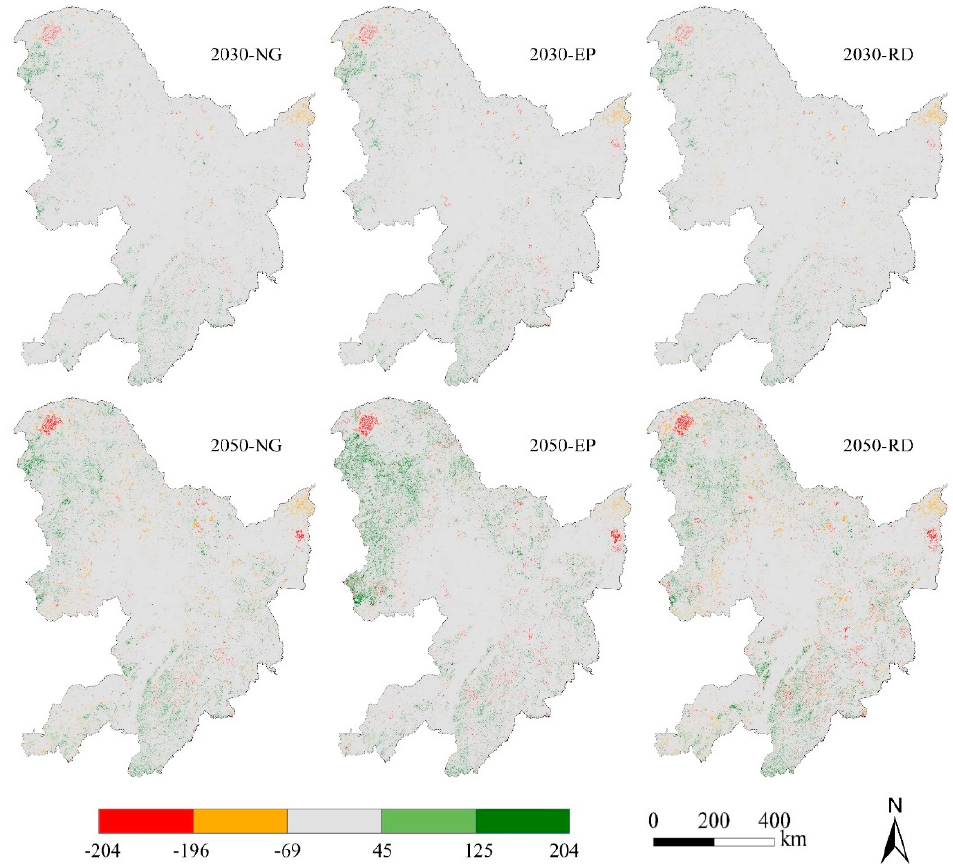
Figure 13. Spatial distribution of FCS in NCF (Mg/hm 2 ).